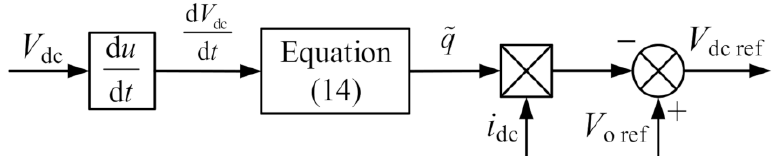
Figure 5. The block diagram of virtual inertia